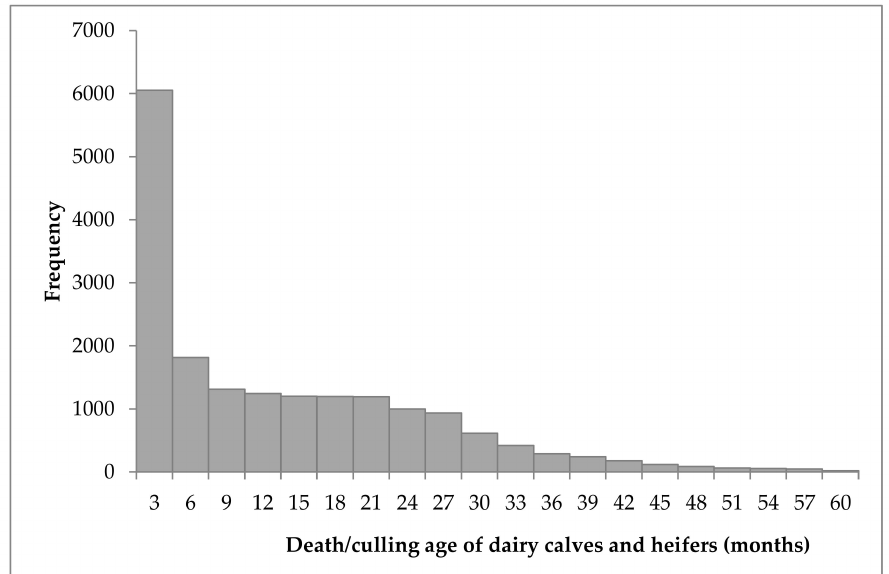
Figure 2. Histogram of death / culling age (months) on dairy calves and replacement heifers.